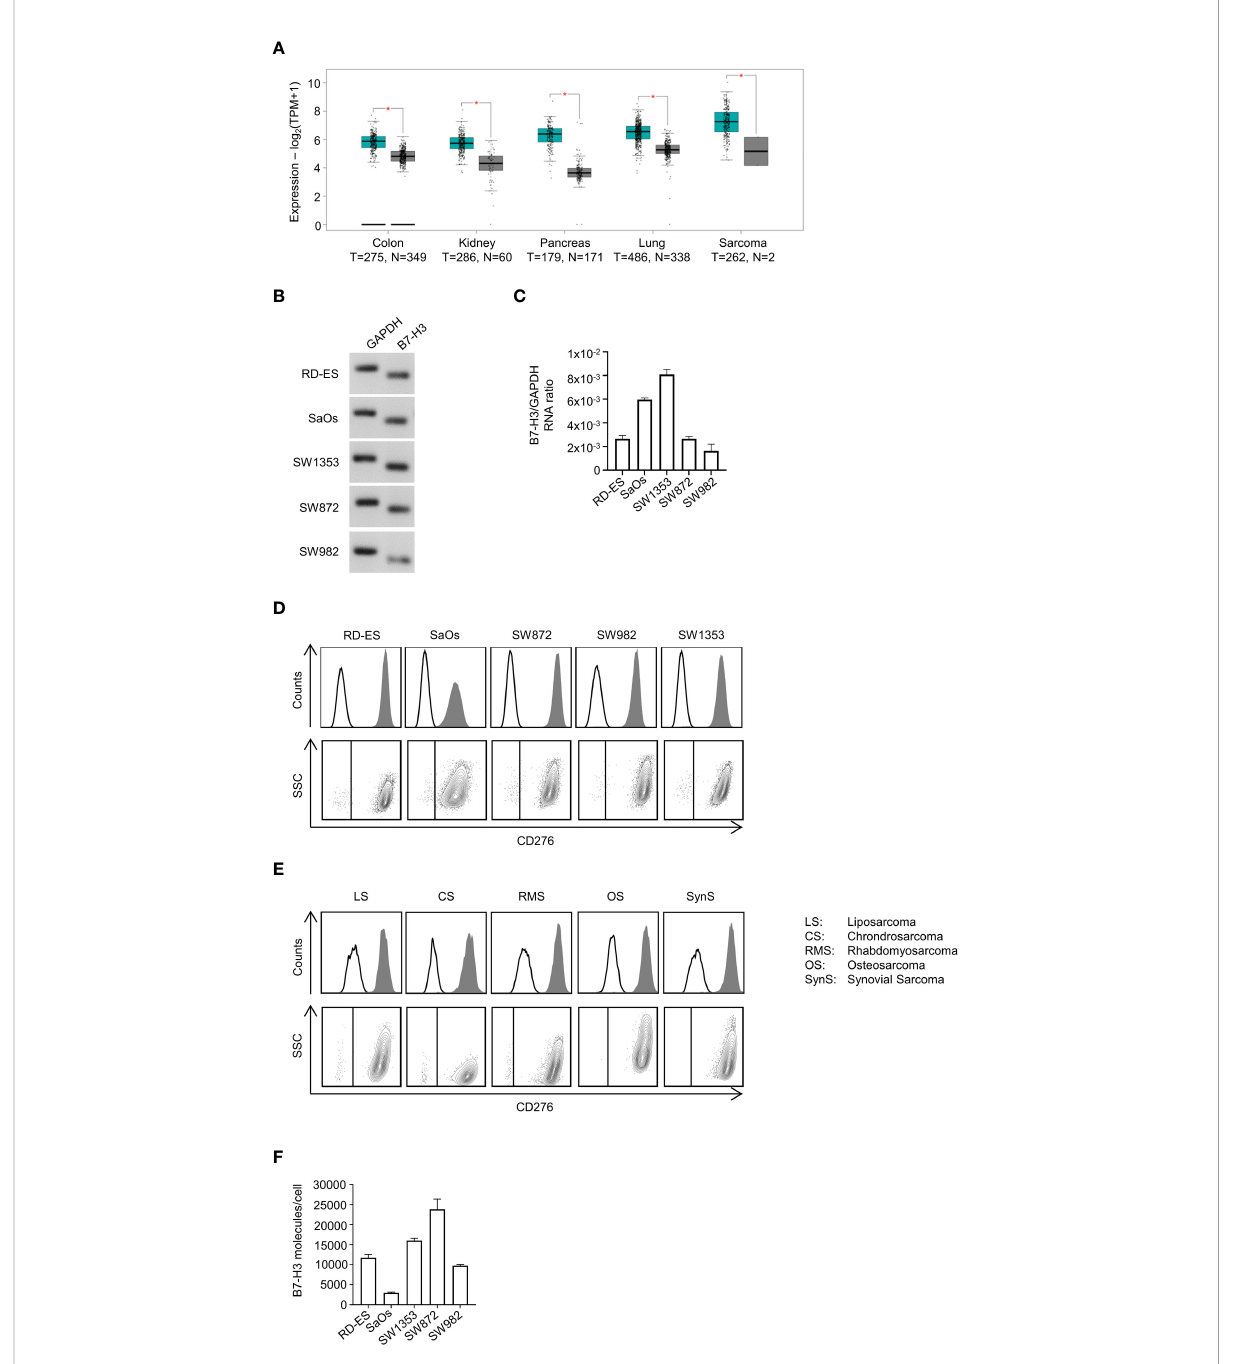
FIGURE 1 Characterization of B7-H3 expression in sarcoma cell lines and patient-derived sarcoma cells. (A) Relative mRNA expression of B7-H3 in indicated tumor and corresponding normal tissues was analyzed using the online web server GEPIA. T, tumor tissue; N, normal tissue (B) B7-H3 mRNA expression of sarcoma cell lines RD-ES, SaOs, SW1353, SW872 and SW982 was determined via RT-PCR with GAPDH serving as control. PCR products were visualized by agarose gel electrophoresis. (C) mRNA expression analysis of B7-H3 mRNA relative to GAPDH mRNA in fi ve different sarcoma cell lines. Results for n=3 experiments are shown. (D, E) Surface B7-H3 expression on the indicated sarcoma cells was analyzed by fl ow cytometry using mAb against B7-H3 (shaded peaks) and corresponding isotype control (open peaks). Exemplary histograms (upper panels) and dot plots (lower panels) from one representative experiment of a total of three with similar results are shown. B7-H3 expression of (D) sarcoma cell lines and (E) patient-derived sarcoma cells of different subtypes dissociated from primary tumor samples are shown, respectively. (F) B7-H3 molecule counts on sarcoma cell lines were determined by FACS. Results for two independent experiments are